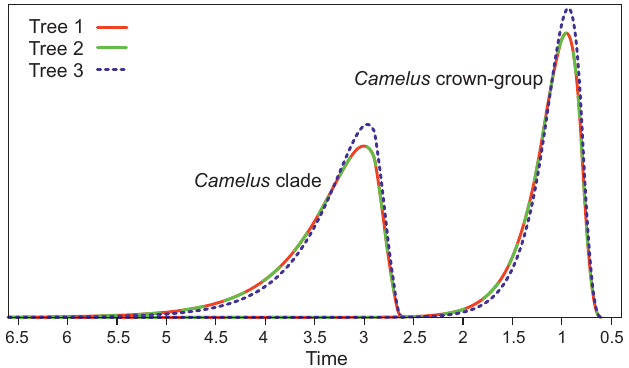
Fig. 3. Probability density of the age of crown (extant) Camelus and of Camelus itself (including older stem-species, namely Camelus grattardi , Camelus sivalensis , and Camelus thomasi ) for the three equiparsimonious trees. These were computed by DateFBD (Didier 2019). The curves for trees 1 (red) and 2 (green) overlap (curve with long dashes). Only tree 3 (blue) yields a different probability density. The probability for a diver- gence time to be in a given time interval is proportional to the surface below its probability density curve for this interval of time (it is exactly the probability of being in the interval if one assumes that the total surface below the probability density curve is equal to